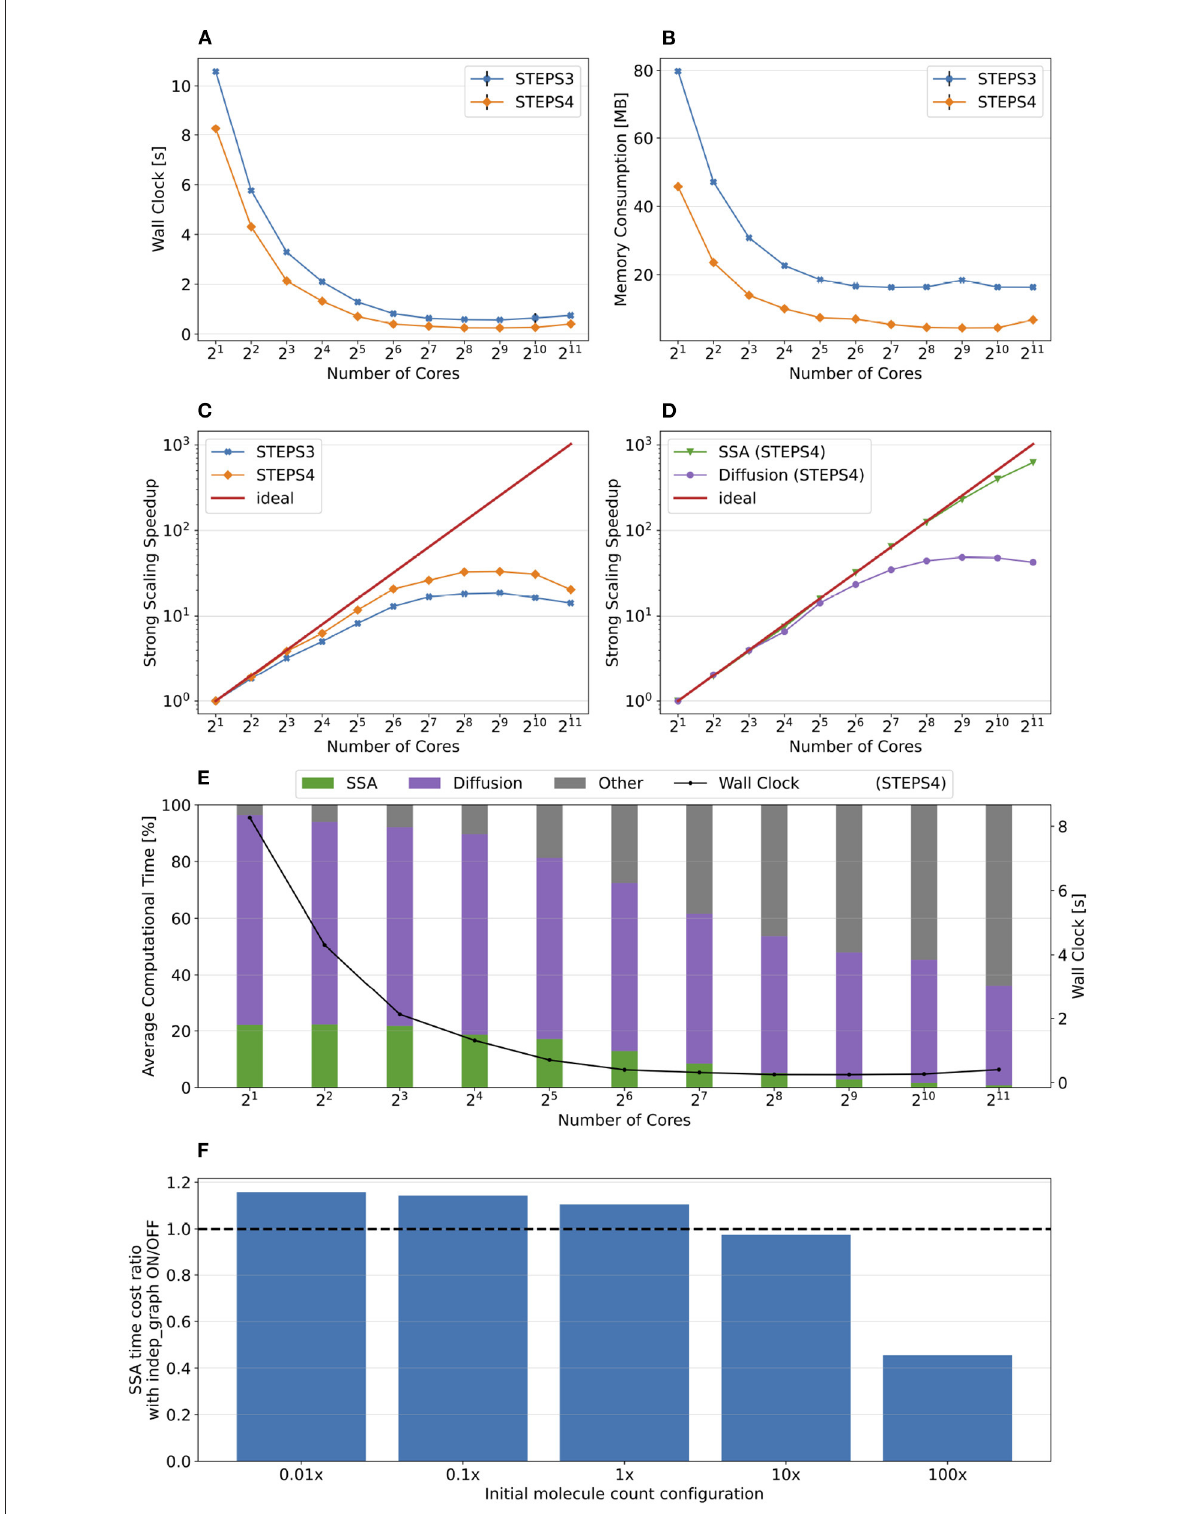
FIGURE8 The performance results and scalability of the simple model. (A) Both STEPS 3 and STEPS 4 implementations demonstrate a steady decrease of time cost early on, then maintain similar time cost beyond 2 6 = 64 cores. (B) STEPS 4 consumes significantly less per-core memory than STEPS 3, ranging from 60% in the baseline simulation, to approximately 30% in high core count simulations. (C) STEPS 4 achieves close-to-ideal